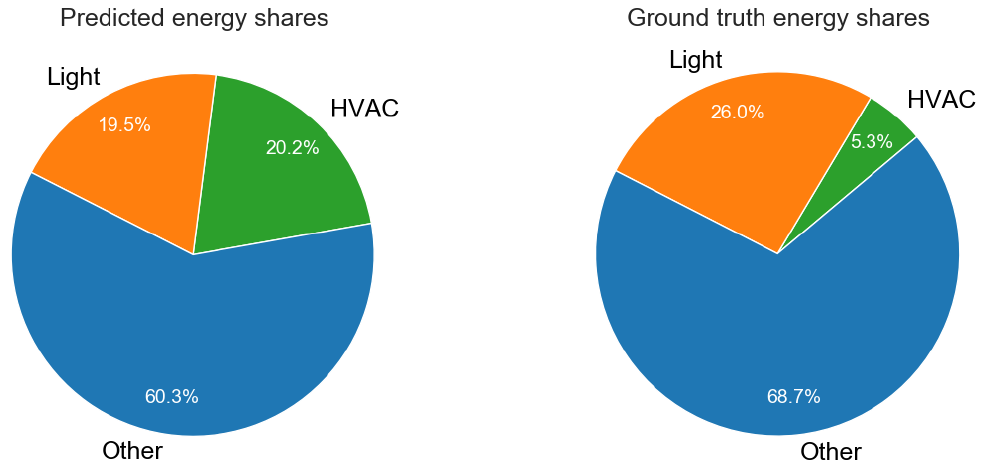
Figure 6. Predicted and ground truth Energy Shares per tertiary disaggregation category on test dataset.